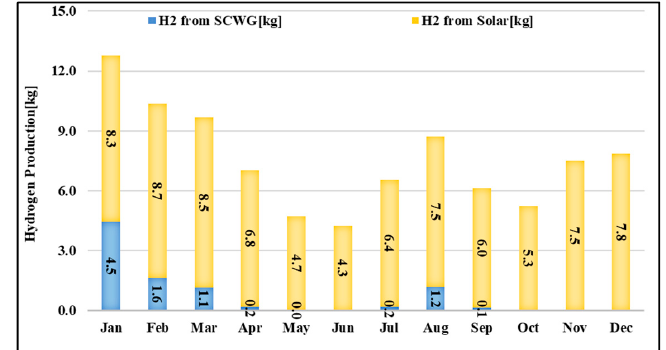
Figure 15. Monthly average hydrogen production in scenario 2.